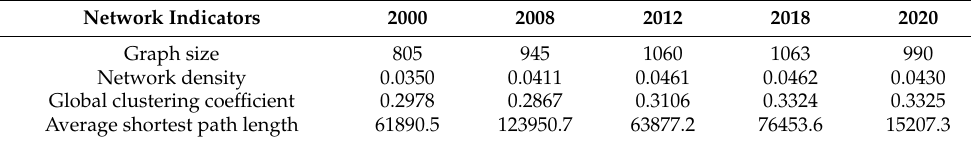
Table 1. Macro Characteristics Description of Global Crude Oil Trade